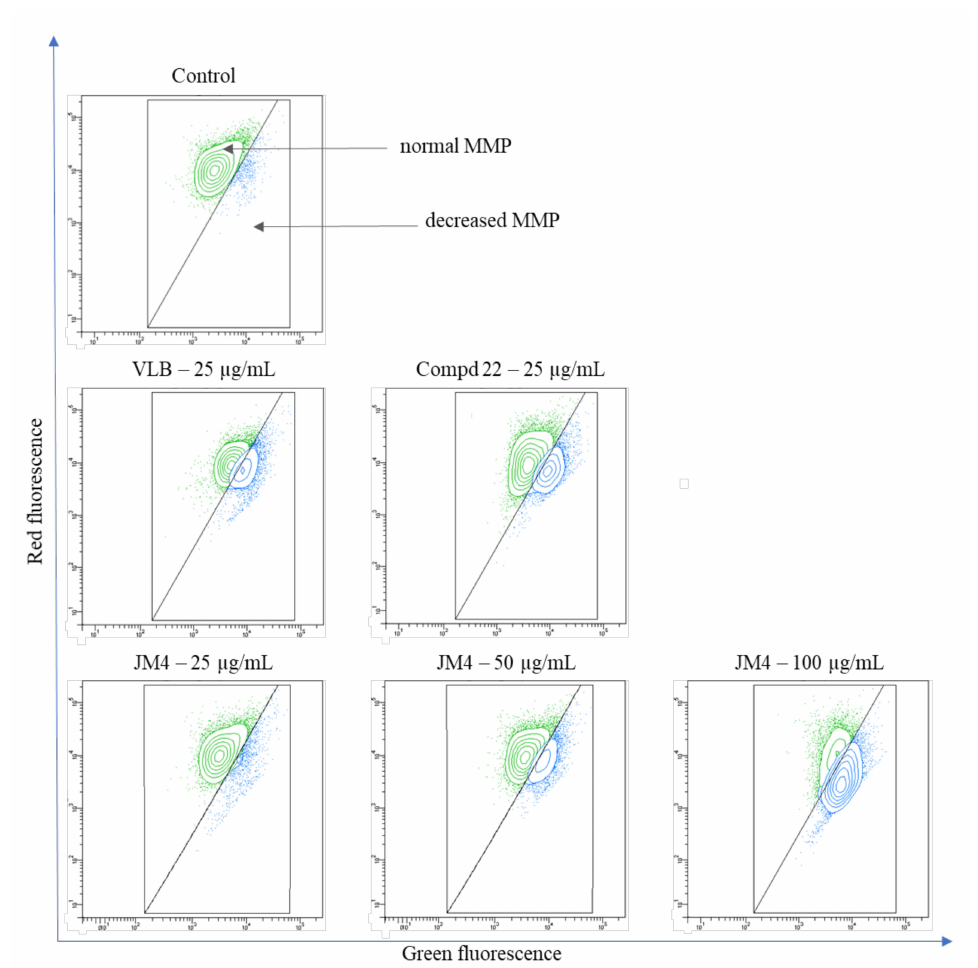
Figure 9. Fluorescence of C32 melanoma cells treated for 24 h with JM4 (25, 50, 100 µ g/mL), 22 (25 µ g/mL) and vinblastine sulfate (VLB) (25 µ g/mL) incubated with mitochondrial membrane potential probe